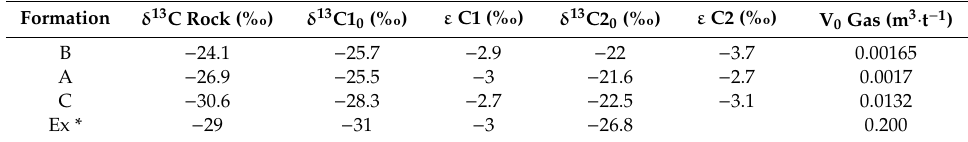
Table 3. Apparent di ff usion fractionation ε for C1 and C2 with calculated estimates of the initial isotope composition δ 13 C 0